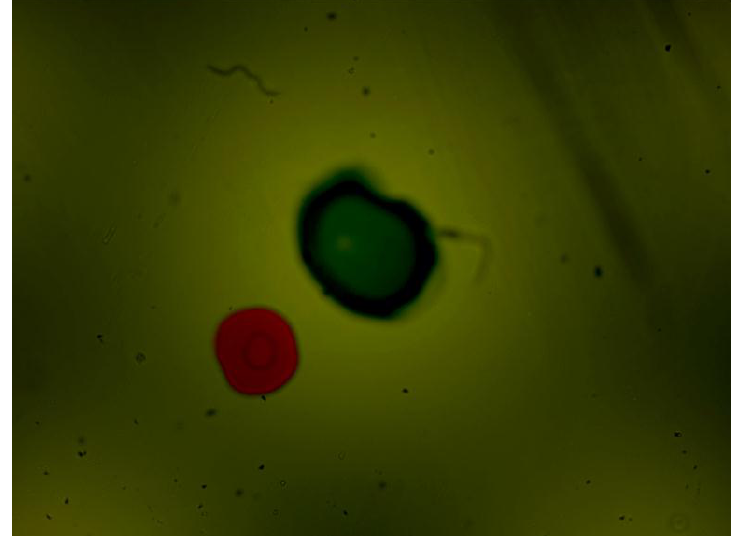
Figure 21. In this case the sensor mounts the Gorilla ® glass. Sample is Castrol Optigear (opaque sample) and the flow speed is approximately 1.0 L/min. Different particles and fibers are present in the image.